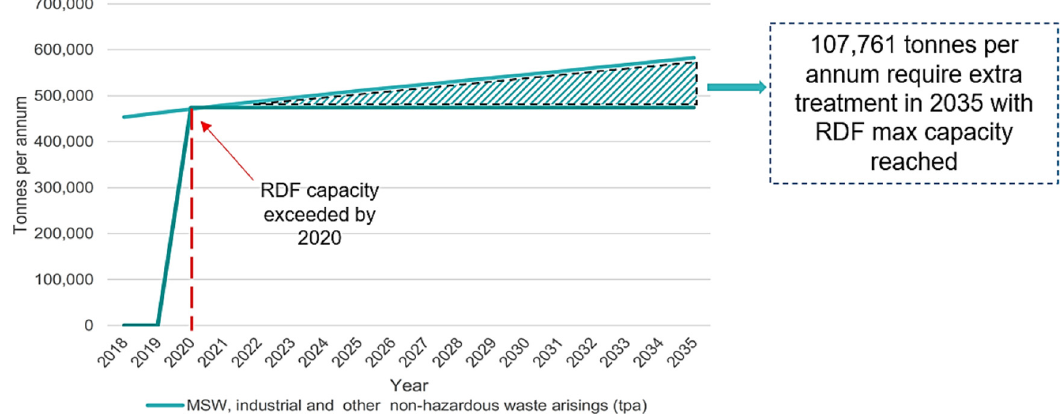
Fig. 8. Projected total waste generation vs RDF capacity [13].